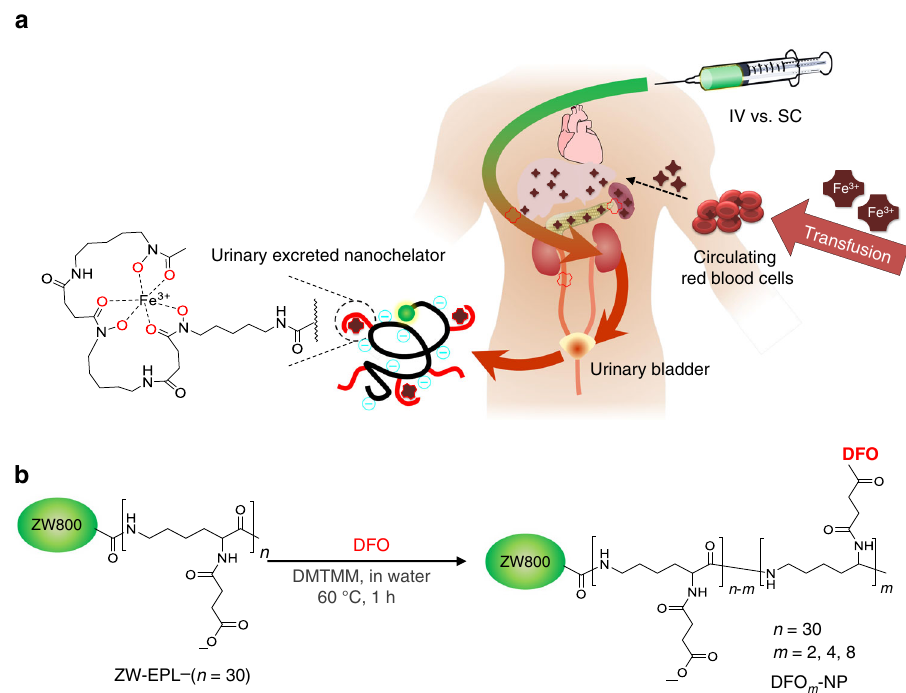
Fig. 1 Renal clearable nanochelators to treat secondary hemochromatosis: a Nanochelators are composed of multiple DFO moieties conjugated on renal clearable EPL backbone to minimize nonspeci fi c uptake into immune-related organs, while ef fi ciently capturing plasma iron and being cleared exclusively by the kidneys. b Synthetic scheme of renal clearable DFO-NPs. m represents the number of DFO moieties conjugated on EPL. NIR fl uorescent ZW800-1C (green color) was conjugated to track the fate of nanochelators in the